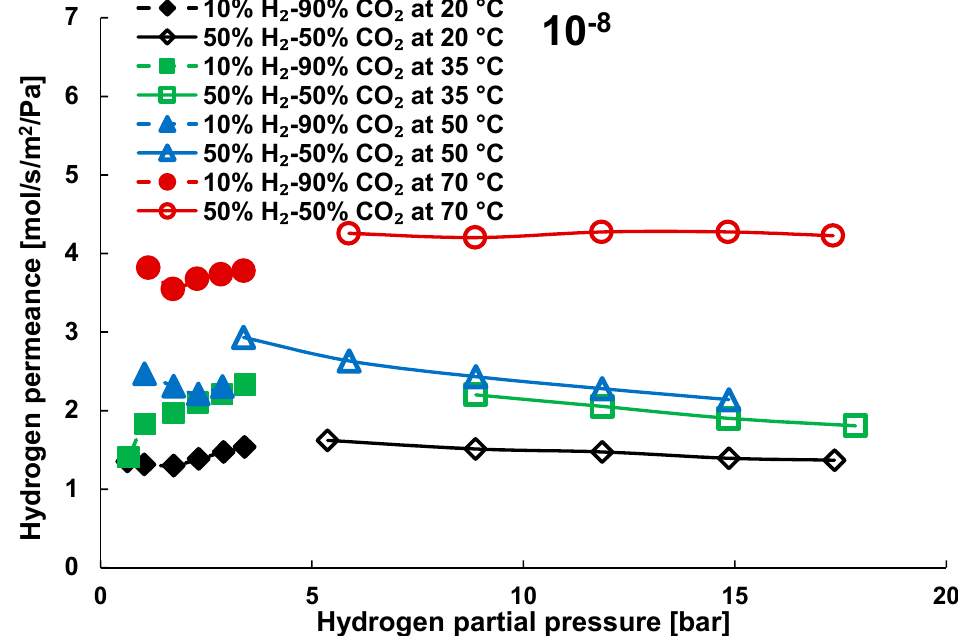
Figure 10. Comparison between permeating hydrogen flow rate in an H 2 -CO 2 mixture with 10% and 50% hydrogen concentration at 20, 35, 50 and 70 °C for CMSM-550.